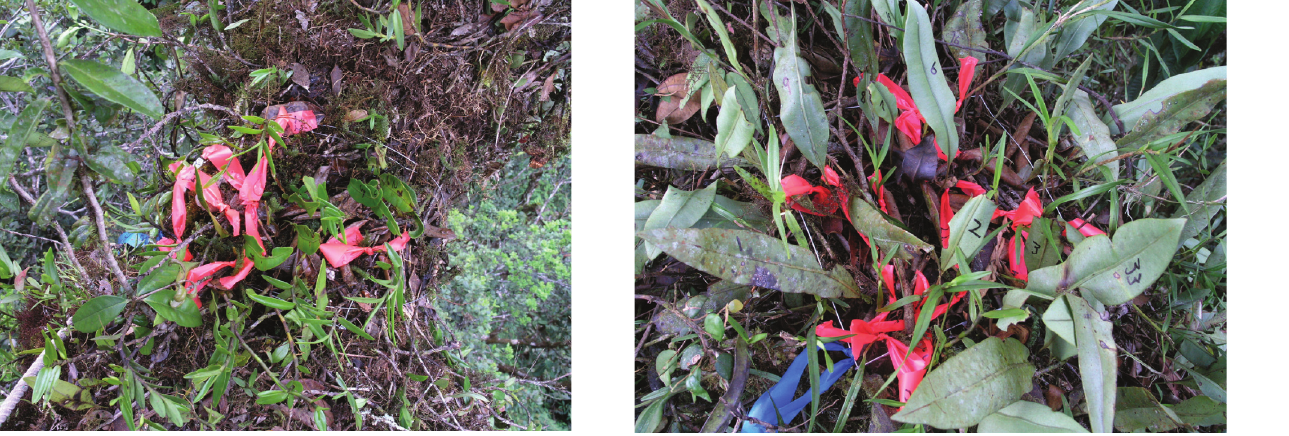
Figure S3. Transplanted mat. A mat from another tree was transplanted into the same